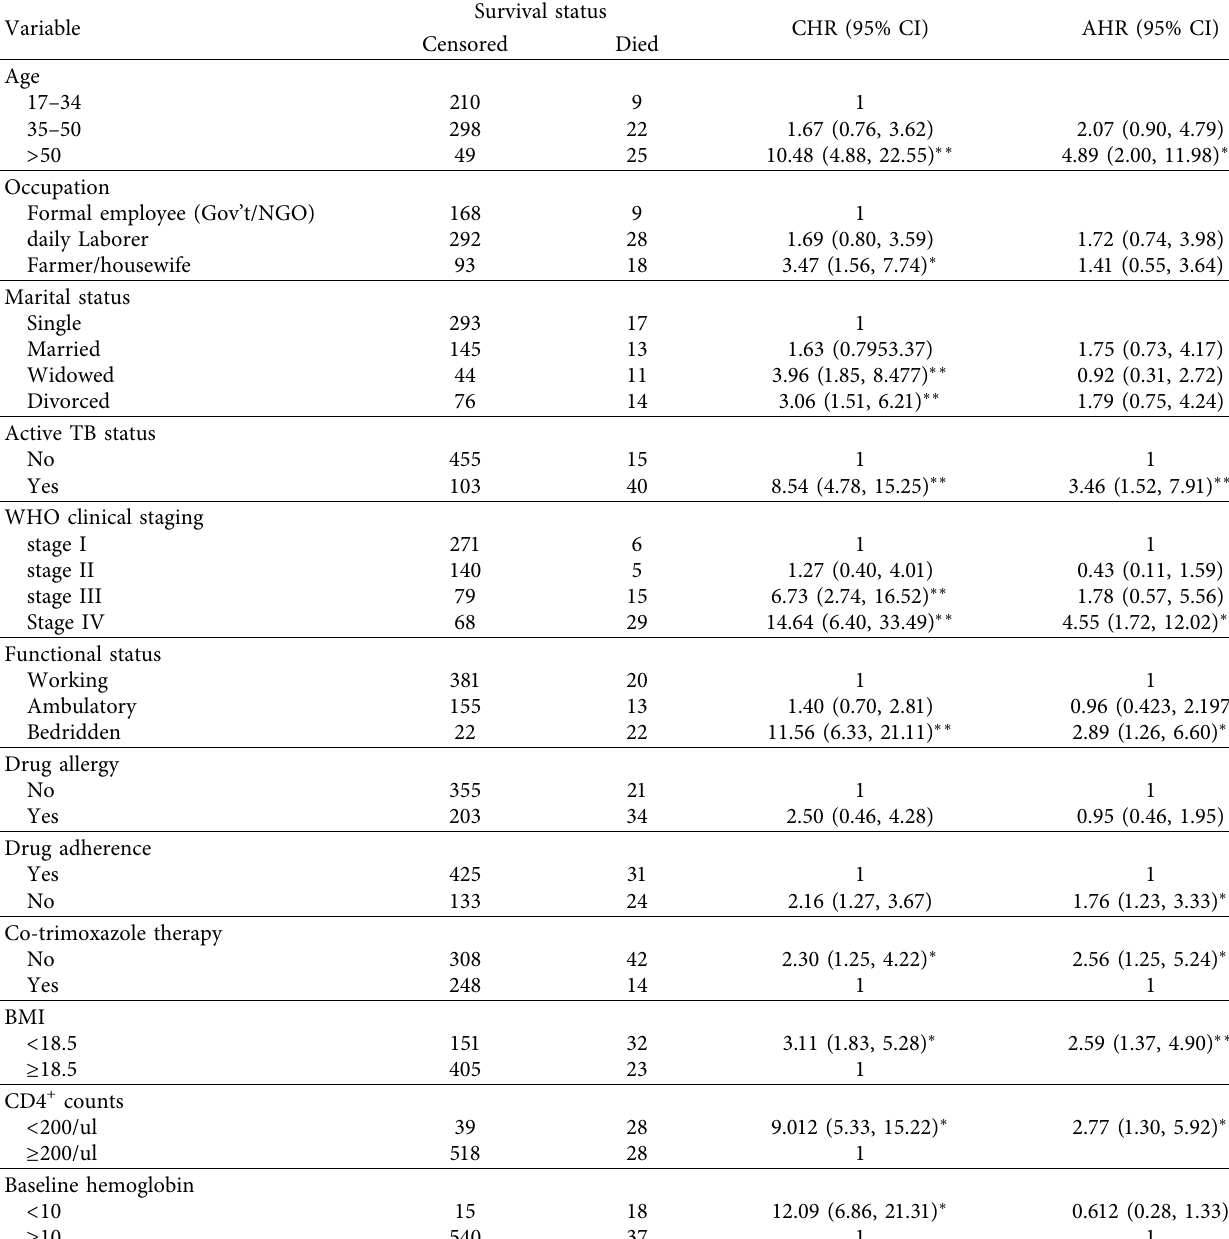
Table 3: Bivariable and multivariable Cox-proportional regression analysis on predictors of mortality in adult patients under ARTin health centers at Addis Ababa, Ethiopia,